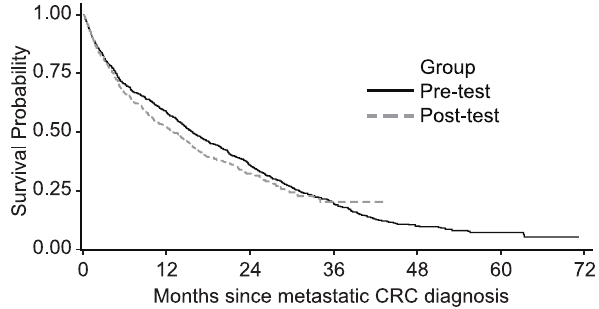
Figure 1. Overall survival in the pre-testing (solid line) and post-testing (dashed line) groups.